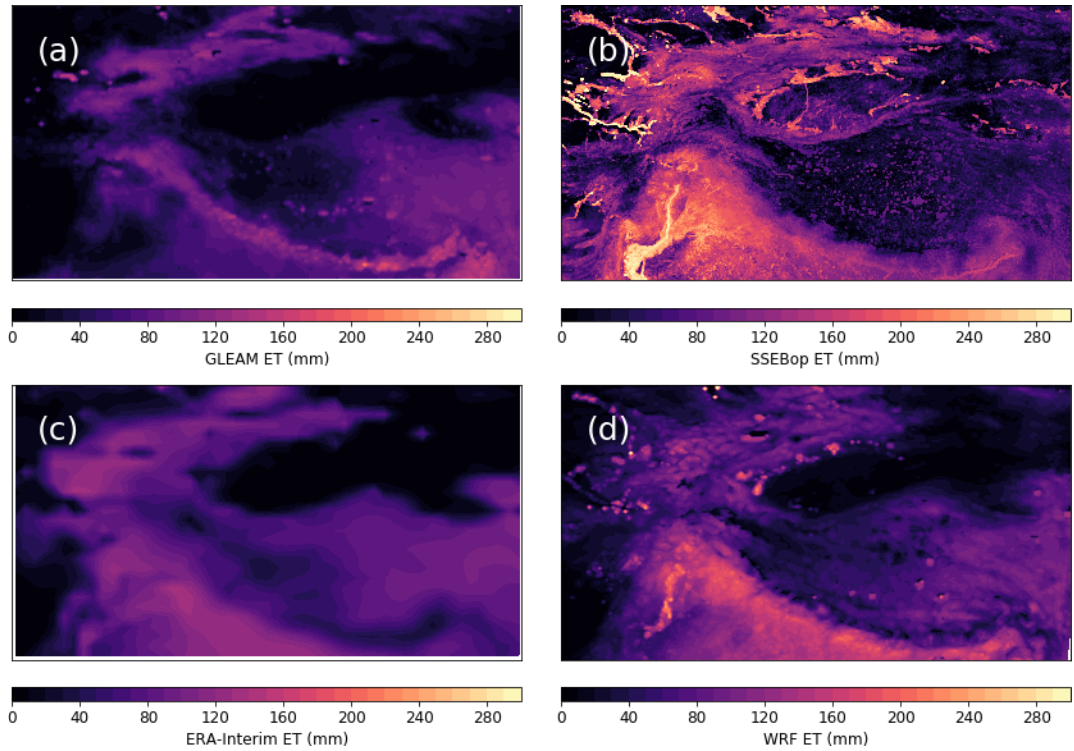
Figure 6. Evapotranspiration for July 2010 from GLEAM (a) , SSEBop (b) , ERA-Interim (c) , and WRF (d) . Mean values for the plotted domains are 44mm (a) , 46mm (b) , 57mm (c) , and 59mm (d) .